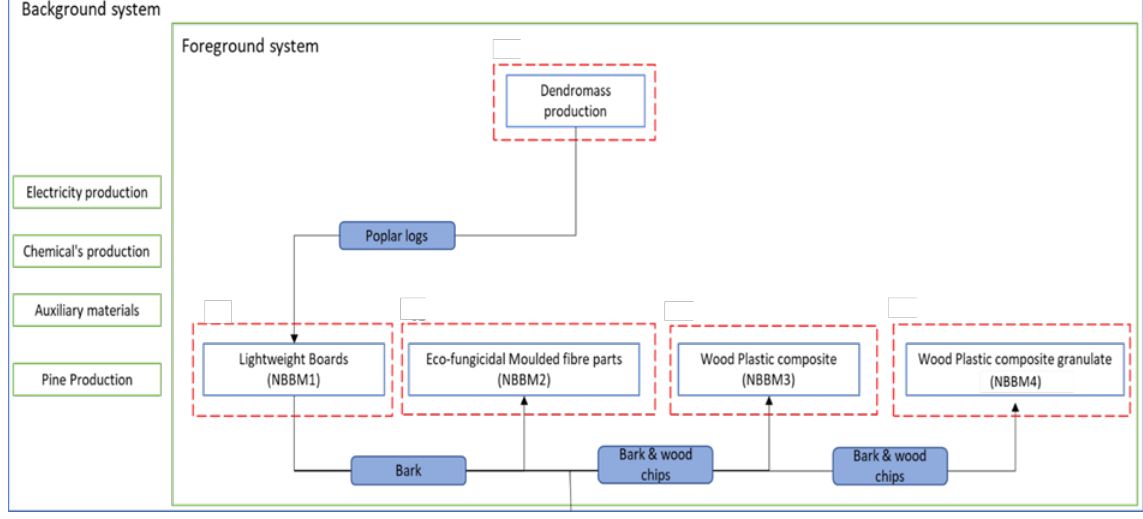
Figure 1. Schematic illustration of the D4EU production system.